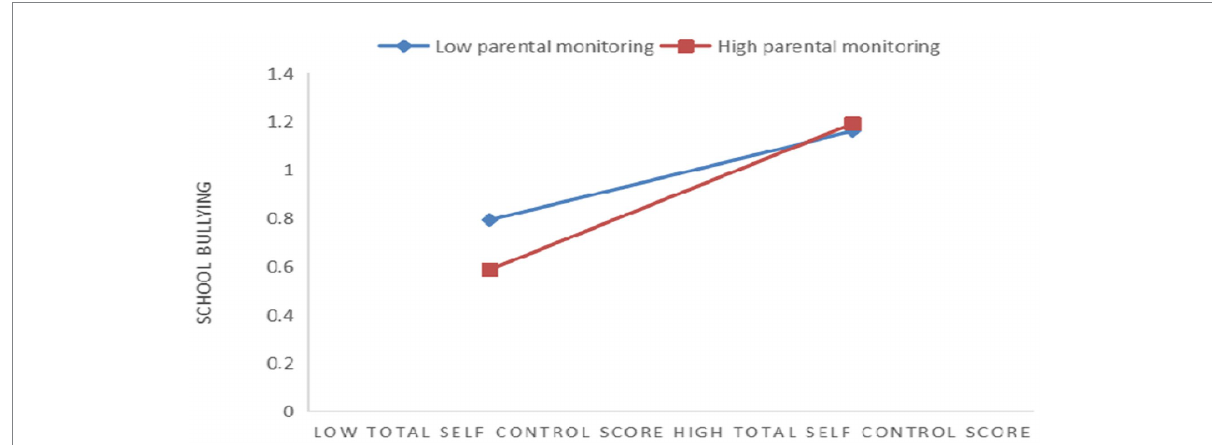
FIGURE 2 The influence of self-control on school bullying: the moderated effect of parental monitoring. The diamond represents low parental monitoring and the square represents high parental